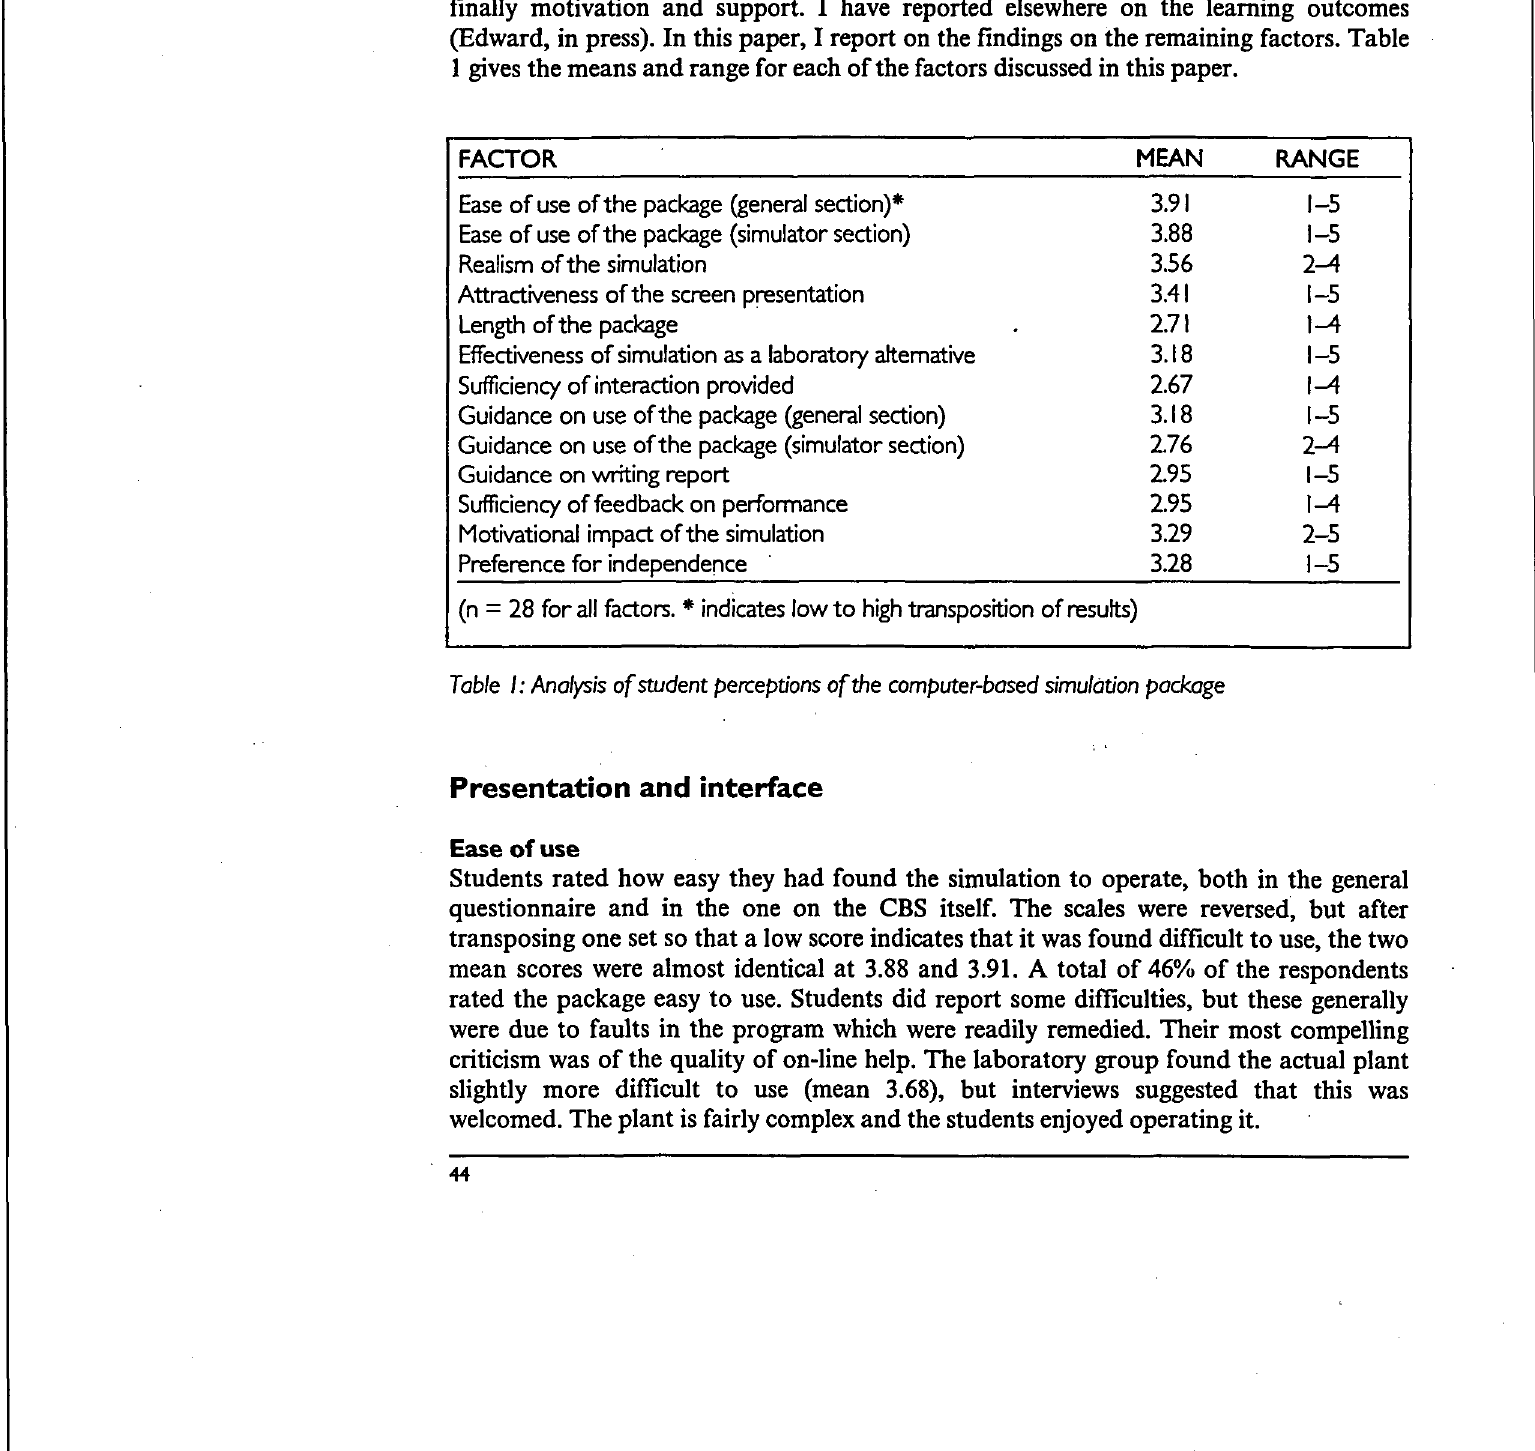
Table I: Analysis of student perceptions of the computer-based simulation package